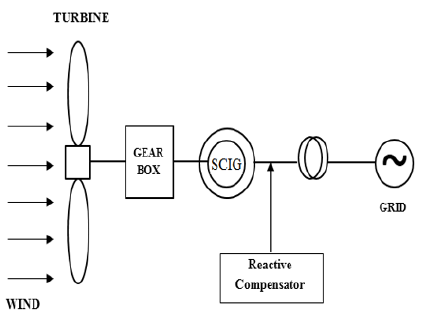
Figure 2. Conventional Integration of SCIG with